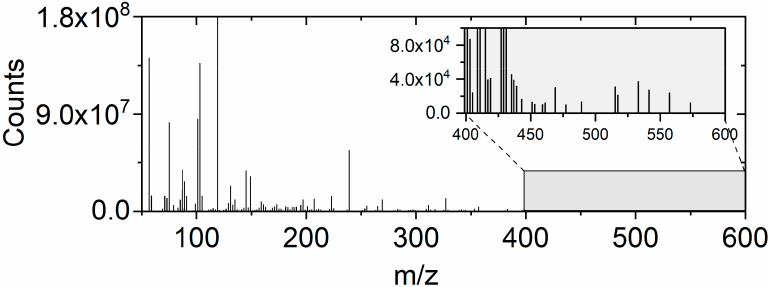
Figure 9. FIA-APCI(-)-HRMS data obtained with a DBE oxidation sample collected at 540